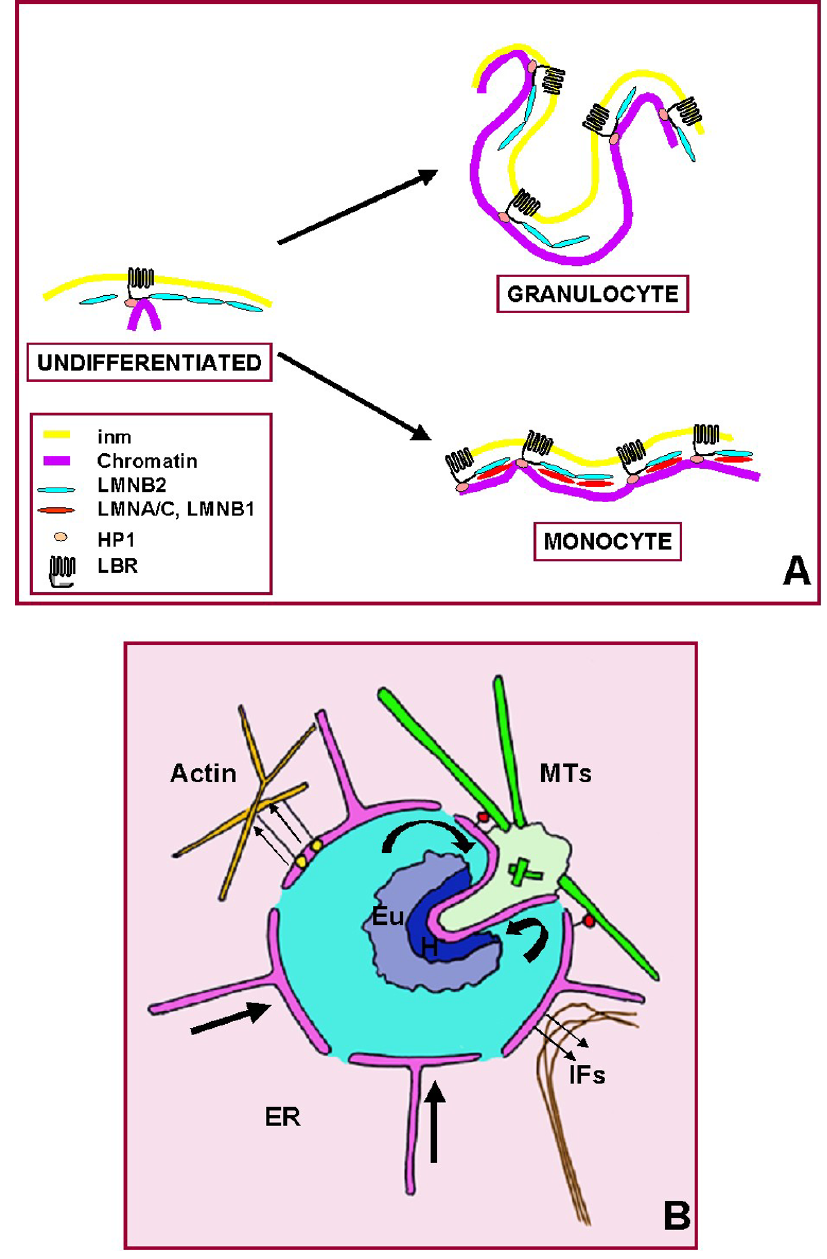
Figure 16 Model for granulocytic nuclear lobulation. A. Postulated changes in nuclear envelope flexibility arising from changes in nuclear envelope composition. HL-60 cell states: undifferentiated; granulocyte, RA treated; monocyte, TPA treated. Abbrevia- tions: inm, inner nuclear membrane; LMNB2, lamin B2; LMNA/C, lamins A/C; LMNB1, lamin B1; HP1, heterochromatin protein 1; LBR, lamin B receptor. Due to a paucity of lamins A/C and B1, the nuclear envelope is believed to be more flexible in the undifferentiated and granulocytic cell states. B. Balance of forces postulated to be affecting granulocytic nuclear shape. Microtu- bules (green) and affiliated dynein motors (red circles) are assumed to produce nuclear envelope invaginations (bent arrows). Actin with affiliated spectrin-like proteins and vimentin are assumed to be pulling outwards on the nuclear envelope (thin arrows). Current evidence does not favor a major contribution by actin; any significant contribution by vimentin is presently unknown. The large straight arrows indicate continued influx of nuclear envelope components from the endoplasmic reticu- lum, allowing sustained membrane growth. Abbreviations: MTs, microtubules; IFs, intermediate filaments; ER, endoplasmic reticulum; Eu, euchromatin; H, heterochromatin. The nuclear compartment is colored blue; the cytoplasm,